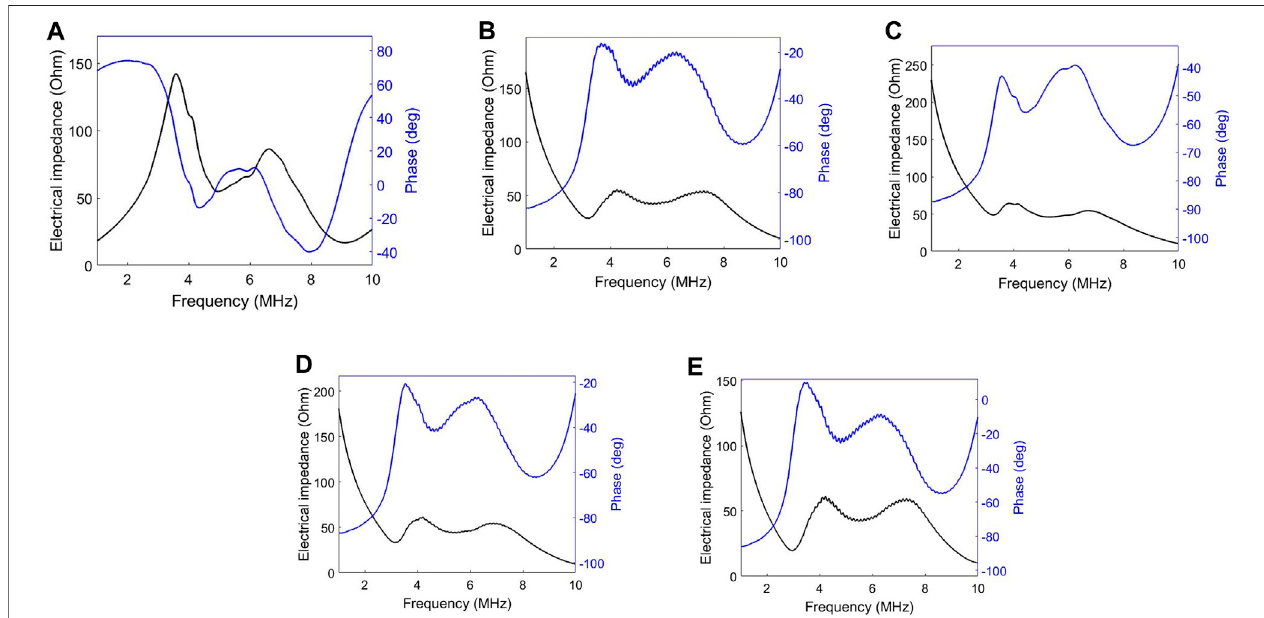
FIGURE 8 | Impedance and phase spectra of ultrasonic transducer: (A) element 1; (B) element 2; (C) element 3; (D) element 4; and (E) element 5.